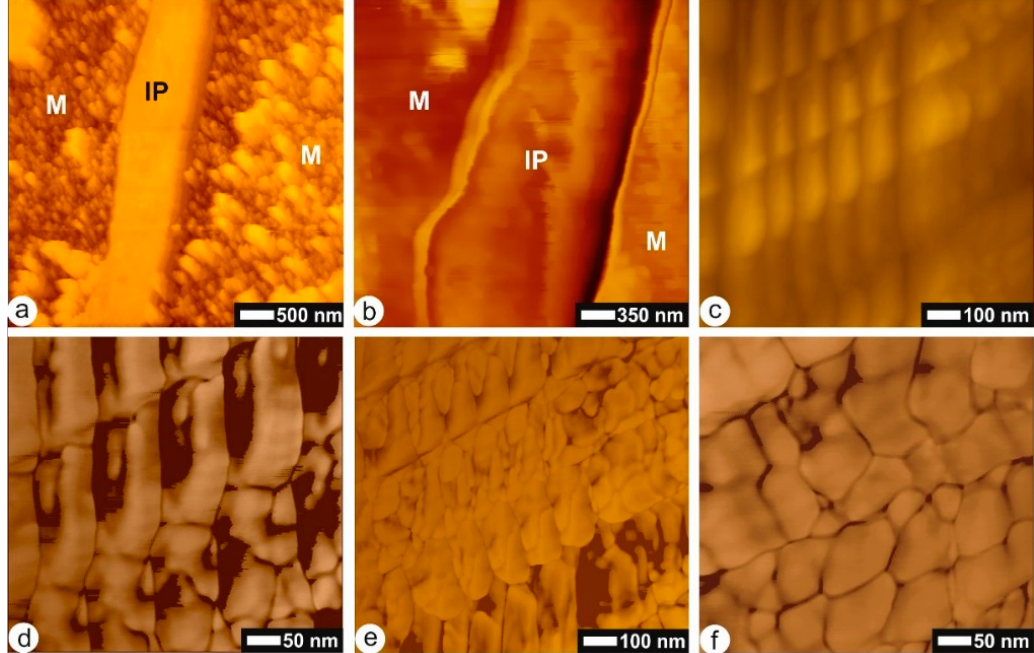
Figure 3. Nanostructure of the prismatic layer of Pinna , atomic force microscope (AFM images). ( a ) Polished, fixed and etched section showing a smooth inter-prismatic membrane (IP) and irregular intra-prismatic zones (M); fixation-etching: formic acid 0.1% and glutaraldehyde 2% for 10 s; dehydrated using alcoholic solutions from 30% to 100%; height image. ( b ) Etched polished section showing the inter-prismatic membrane; etching and fixing solution: formic acid 0.1% and glutaraldehyde 2% for 10 s; phase image. ( c ) Polished and etched transverse section showing the lateral surface of the inter-prismatic membrane, showing some growth layers, and the regular arrangements of organic subunits; Mutvei’s solution for 8 min; phase image. ( d ) Same sample, detail of 3c; height image. ( e ) Another lateral face of a prism in the same sample; phase image. ( f ) Detail of the compact arrangement of the molecules; phase image.